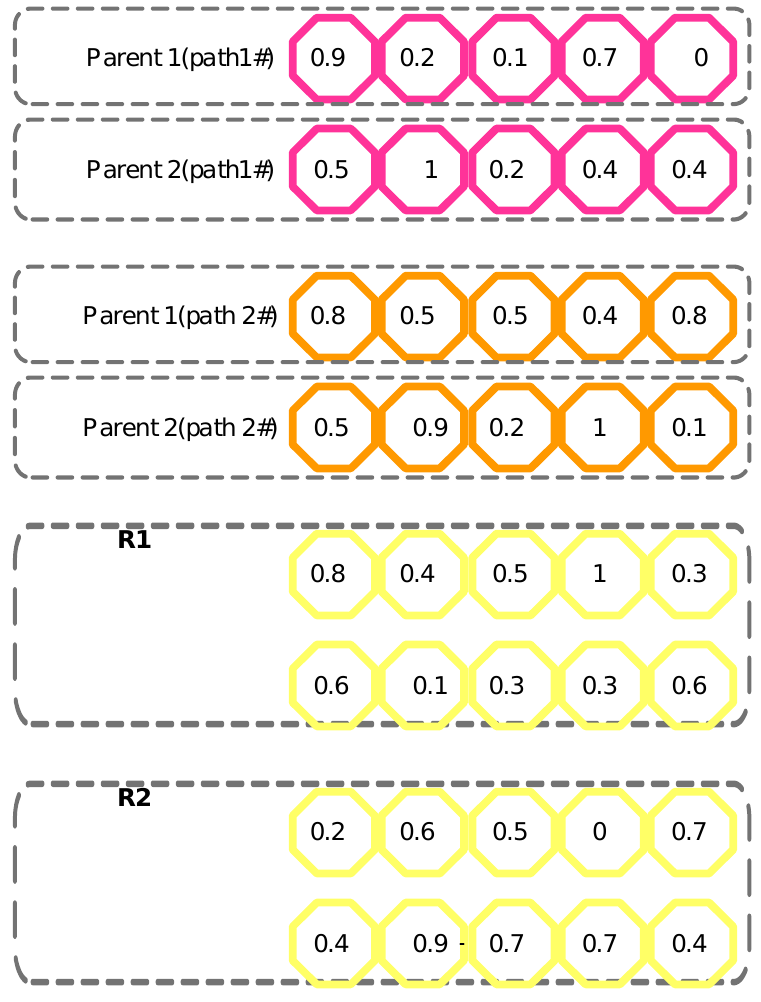
Fig. 6. Continuous